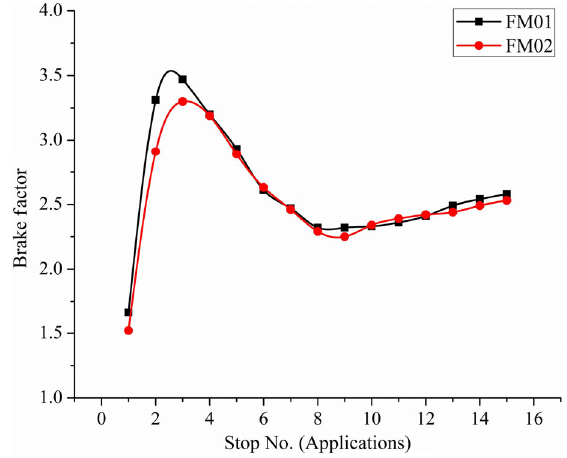
Fig. 9 Wet recovery performance of developed